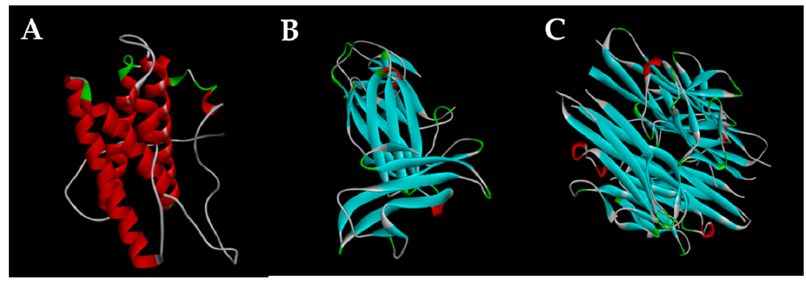
Figure 2. IL-6, IL-12 p40, and TNF- α proteins. ( A ) 2L3Y, ( B ) 1F42 and ( C ) 2AZ5. Table 2. Docking simulation results with docking score energy (DS) and root-mean-square deviation (RMSD) between isolated compounds ( 3 , 4 , 6 , 11 , and 12 ) and the 2L3Y protein. Compounds DS (kcal.mol − 1 ) RMSD (Å)